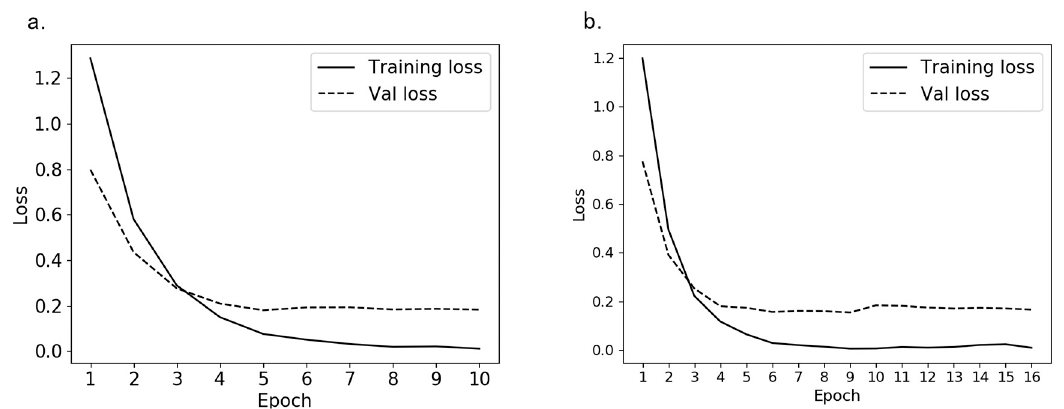
Figure 8. The loss reduction during the training process; ( a ) training 10 epochs loss reduction; ( b ) training 16 epochs loss reduction.